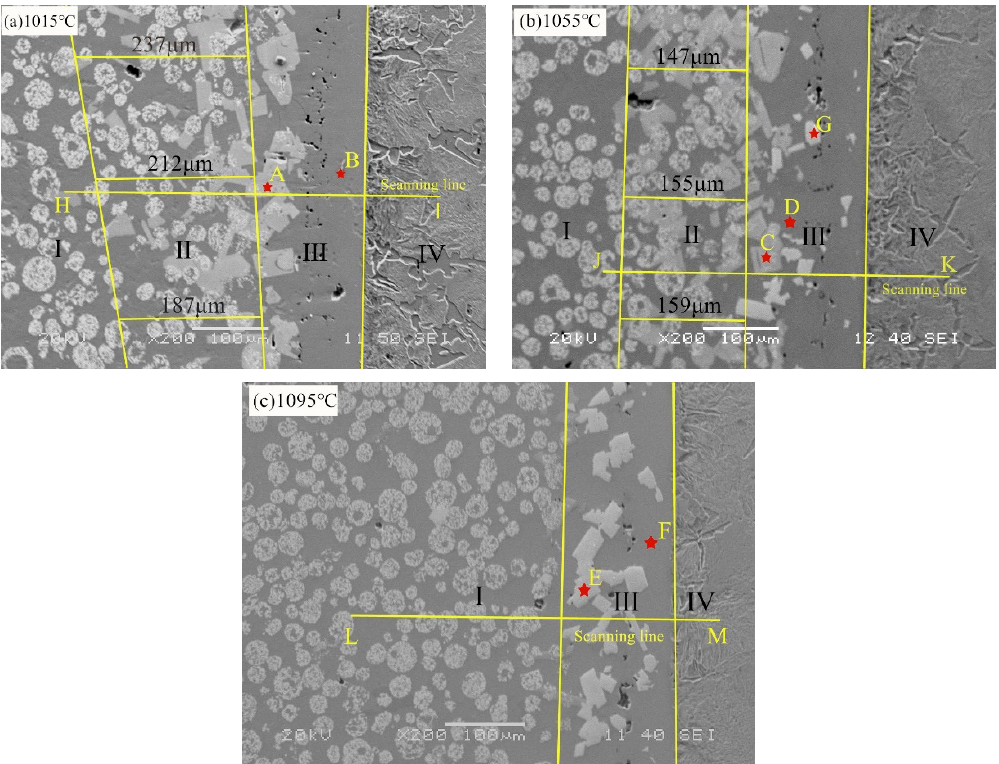
Figure 7. Microstructures of the bonding area of the coatings and substrate brazed at different temperatures: ( a ) 1015 °C, ( b ) 1055 °C, and ( c ) 1095 °C.